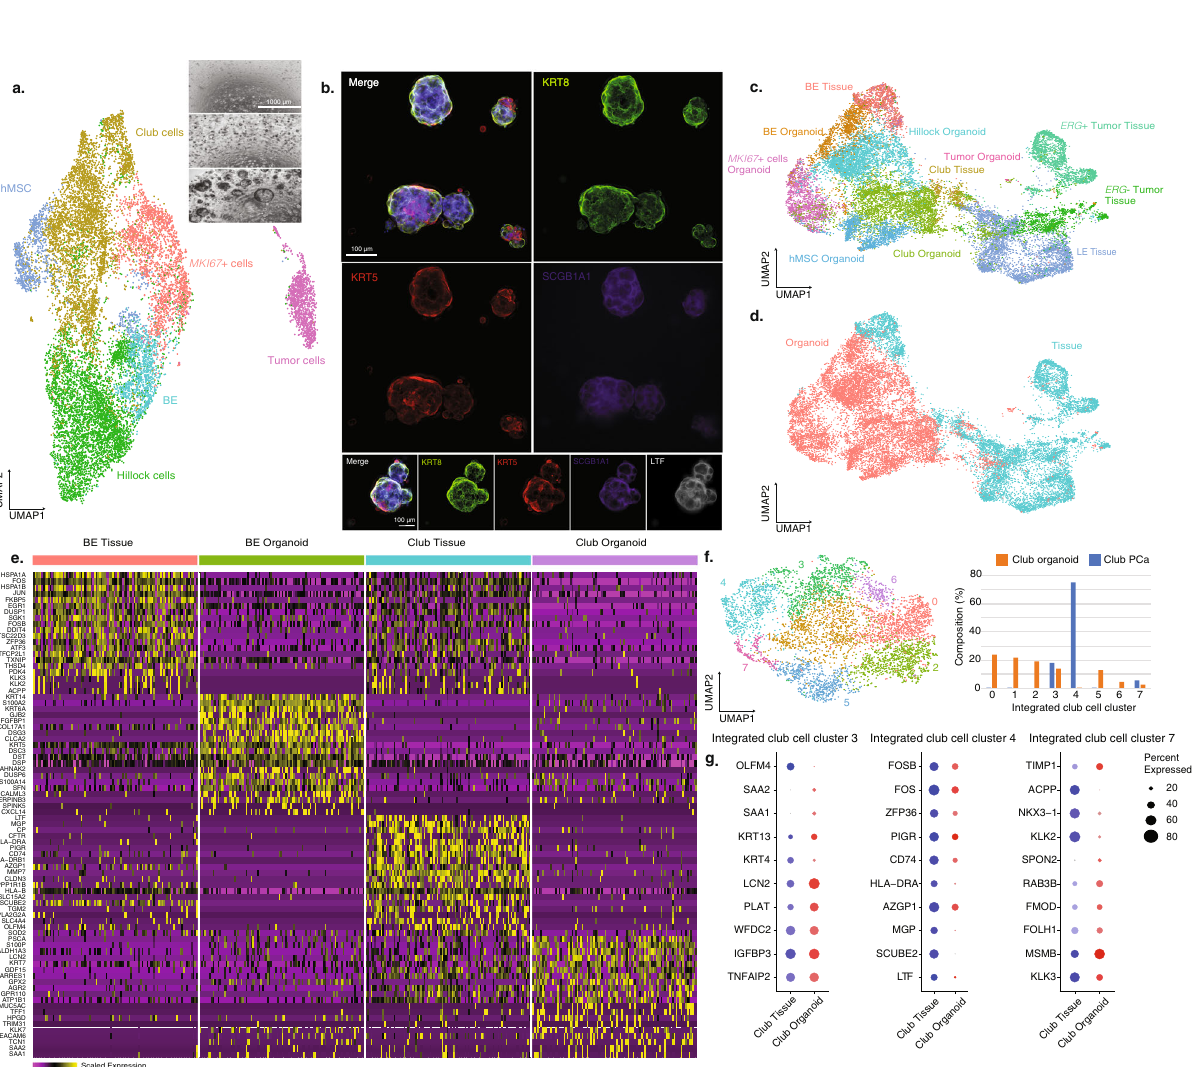
Fig. 7 CD4 T-cell subsets associated with ERG status and common upregulation of PD-1 and interferon-gamma signaling in the ERG − tumor microenvironment. a UMAP of T-cells labeled by different cell types (left) and ERG + or ERG − patients (right). b Cell composition comparison between ERG + and ERG − patients for all T-cell cell types. Signi fi cance levels are labeled in differentially enriched clusters (*** P < 0.001, two-sided FET; CD4 T-cell cluster 1: P = 4.28e-13; CD4 T-cell cluster 2: P = 1.08e-27). c UMAP of stromal cells labeled by different cell types (left) and ERG + or ERG − patients (right). d Cell composition comparison between ERG + and ERG − patients for all stromal cell types (*** P < 0.001; P = 1.15e-31, two-sided FET). Signi fi cance levels are labeled in differentially enriched clusters. e Visualization of the intersections amongst signi fi cantly upregulated (top) and downregulated (bottom) gene sets within C2CP gene-set collection for tumor cells, two clusters of differentially enriched CD4 T-cell clusters, and stromal cells. Signi fi cant Gene Set Enrichment Analysis (GSEA) results are represented by circle below bar chart with individual blocks showing “ presence ” (green) or “ absence ” (gray) of the gene sets in each intersection. P value signi fi cance of the intersections are represented by the color intensity of the bars. f GSEA results for the ERG - patient-enriched CD4 T-cell cluster compared to the ERG + patient-enriched cluster on the common upregulated gene sets ( N = 14). Gene counts for the corresponding gene set are indicated by marker radius. Statistical signi fi cance levels (FDR) are shown by color gradient. Reactome PD-1 and Interferon- gamma signaling pathways are highlighted in red. g Gene expression heatmaps of genes in the Reactome PD-1 and Interferon-gamma signaling pathways for tumor cells, CD4 T-cells and stromal cells in both ERG + and ERG − patients. Source data are provided as a Source Data fi le.